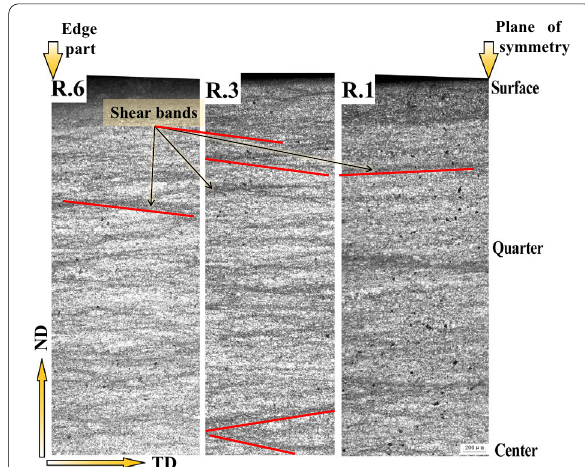
Figure 9 Microstructures in the thickness direction of the samples along the transverse direction of the as-rolled AZ31 plate with a thickness of 5.6